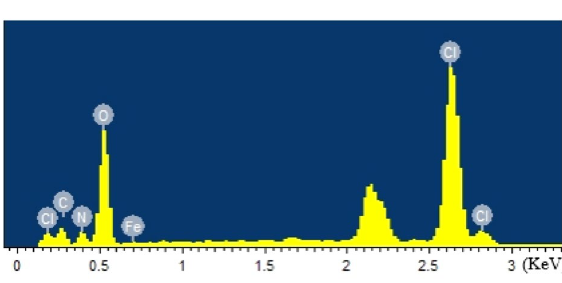
Figure 4. Element distributions of laminated AP composite from EDS results.